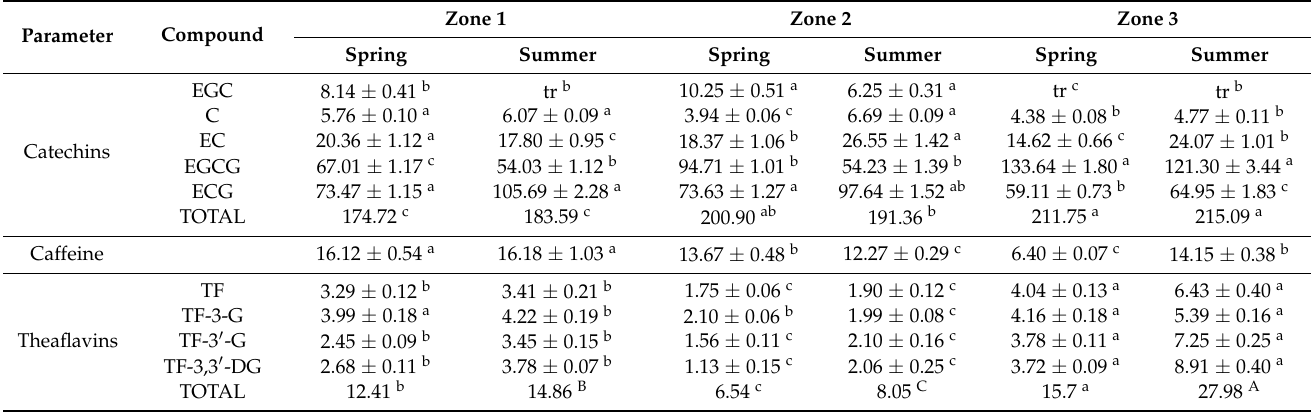
Table 1. Catechins, caffeine, and theaflavin contents in different tea plantation zones (mg/g dry weight) 1